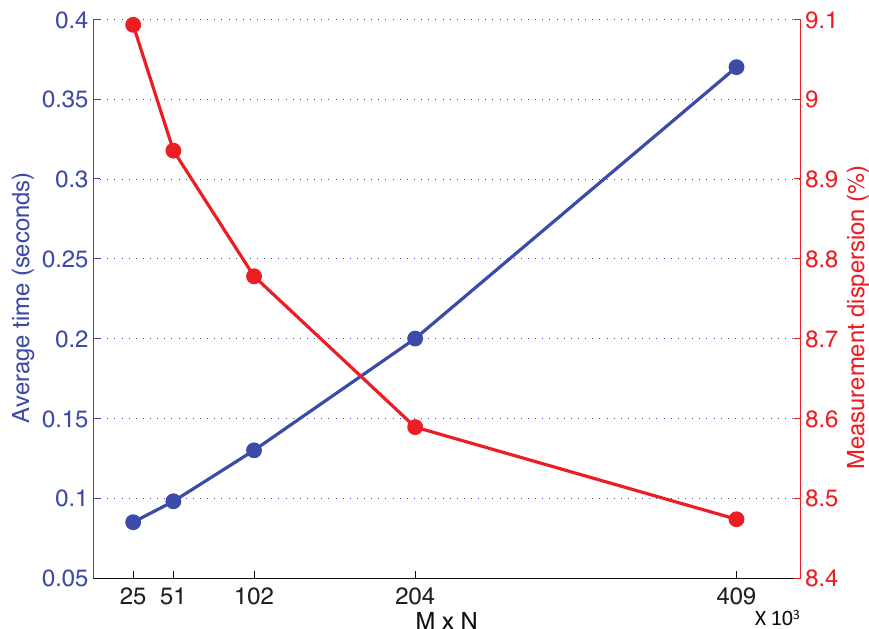
Figure 13. Average time and measurement dispersion using different Radon transform sizes. All indoor environments have been used to carry out these comparisons by calculating eight different altitude estimations in each